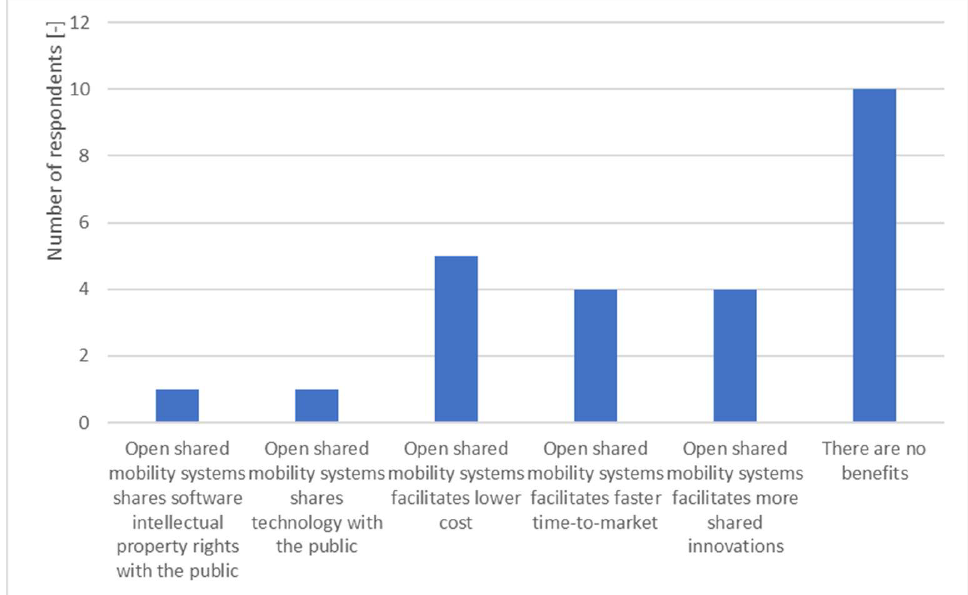
Figure 15. Benefits of open innovation.